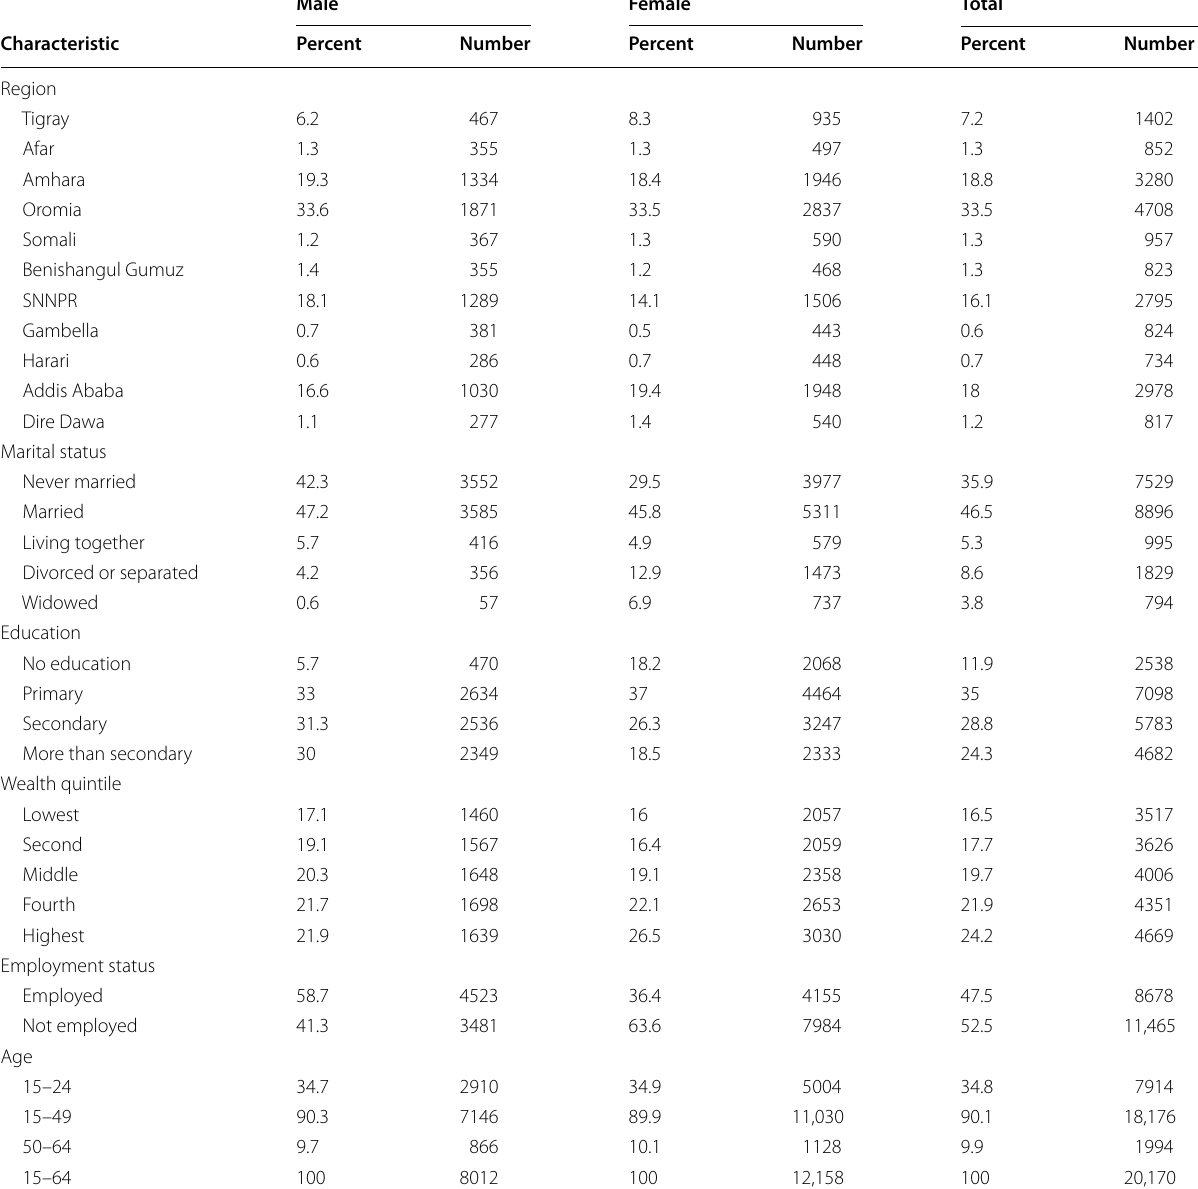
Table 1 Demographic characteristics of the adult population in Urban Ethiopia (2017/18) Male Female